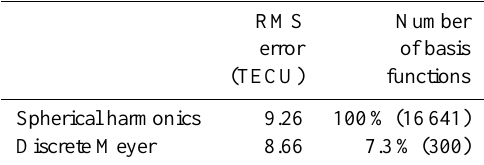
Table 3. RMS error (values are in TECU) of the VTEC map ob- tained with a 3DVar scheme using spherical harmonics and discrete Meyer with a noise term added to the observations. Only the VTEC coefficients where there is ray coverage were considered. The per- centage of basis functions with non-zero coefficients is also shown and within brackets the number in absolute